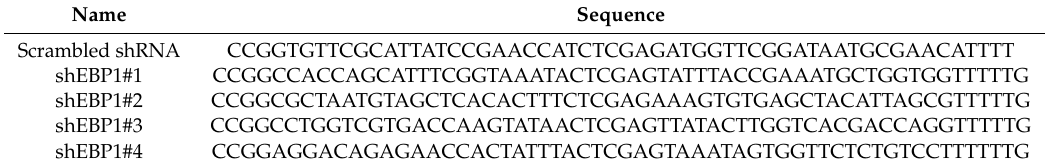
Table 1. Oligosequences of the